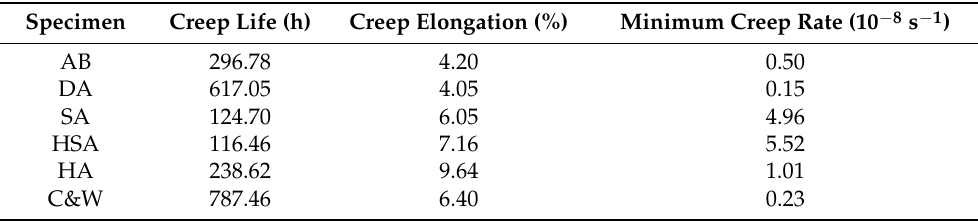
Figure 8. Plots showing creep properties of EBM IN718 for as-built and various post-heat-treated specimens along the building direction; ( a ) depicts the creep curves at 650 ◦ C and 650 MPa, and ( b ) shows the correlations between creep rate and time. Table 3. The creep properties of as-built and various post-heat-treated specimens presented in Figure